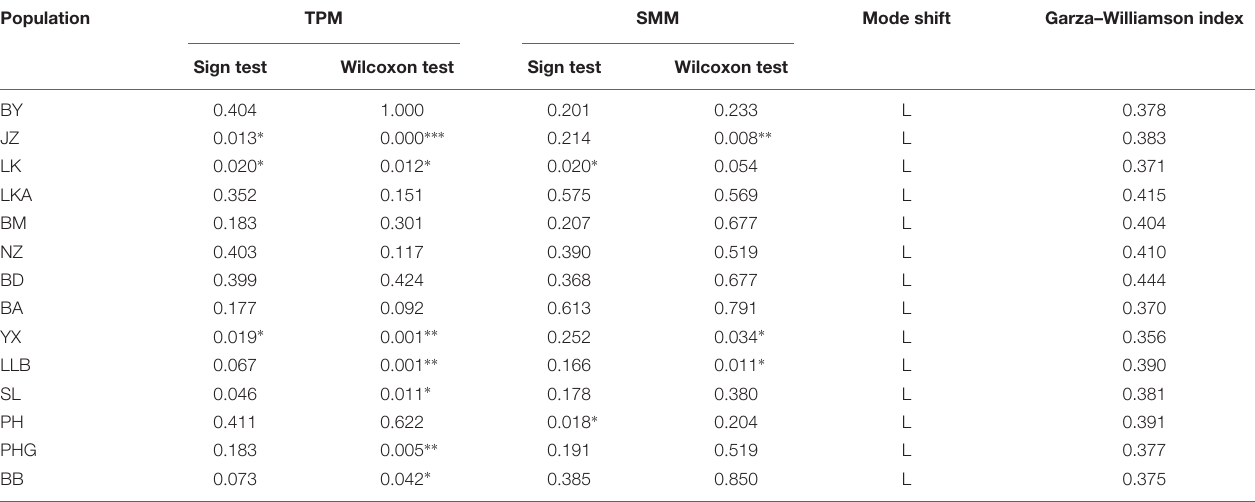
TABLE 3 | Bottleneck analyses for 14 populations of C. segmentifida .